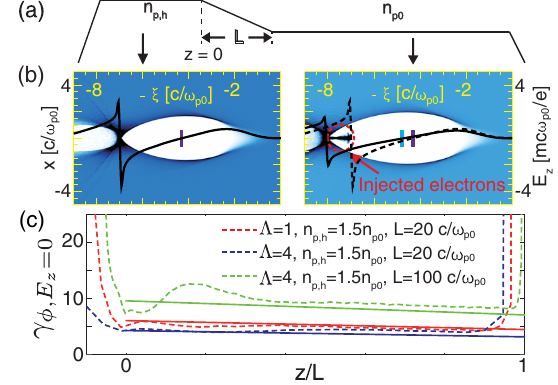
FIG. 1. (a) Schematic of density downramp injection. The plasma density decreases linearly from n p;h at z ¼ 0 to n p 0 at z ¼ L . (b) The plasma wake produced by a short electron bunch with Λ ¼ 1 before (left) and after (right) it propagates through the density downramp. The black lines are the on-axis E z and the purple (blue) marker indicates the position where E z ¼ 0 when the beam is before (after) the ramp. (c) Evolution of the phase velocity γ ϕ ;E from Eq. (1) (solid lines) and 3D PIC z ¼ 0 simulations (dashed lines). The parameters are: γ b ¼ 2500 ; n 0 . 5 c when Λ ¼ 4 ω p 0